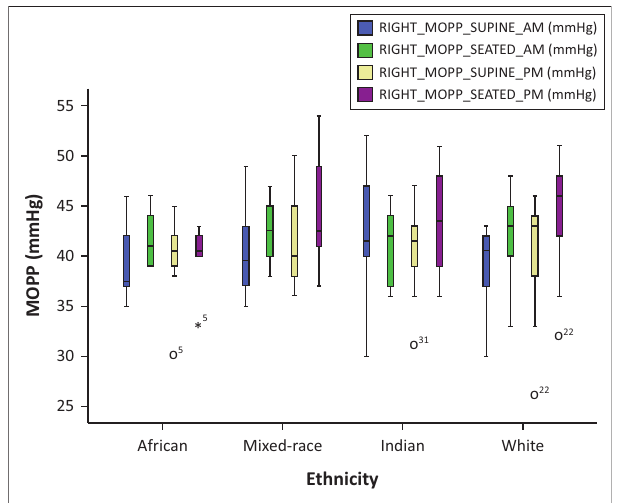
FIGURE 2: Box plot for mean ocular perfusion pressure and different ethnicities in the seated and supine position in the morning and afternoon.